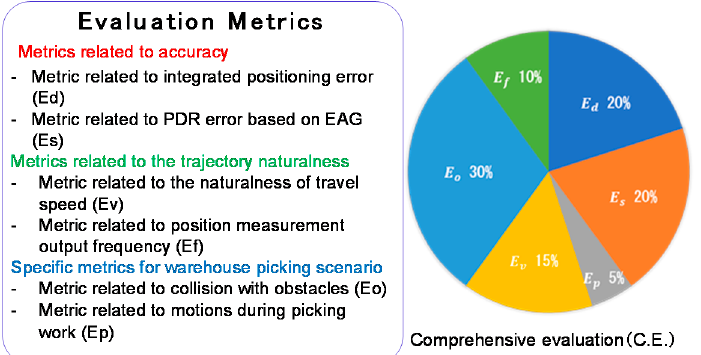
Figure 4. Submitted trajectories are supposed to be evaluated according to multi-faceted evaluation metrics. The final winner is determined by a comprehensive evaluation score (C.E.), which is calculated from the weighted sum of the elemental evaluation metrics.